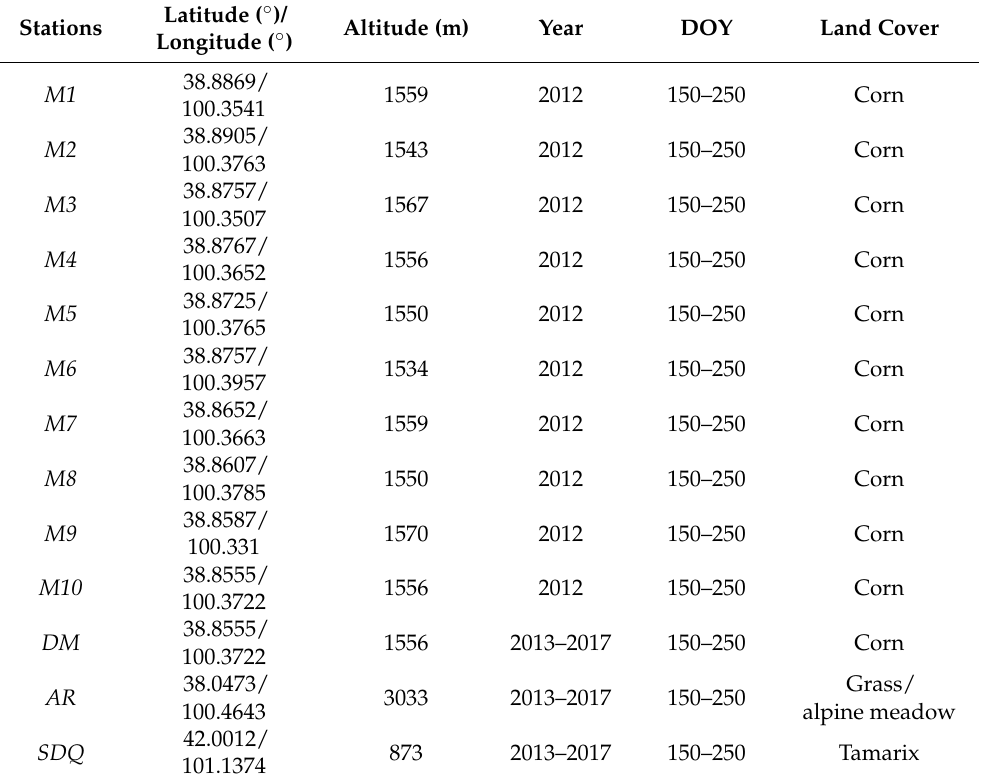
Table 1. Stations of the evaluated